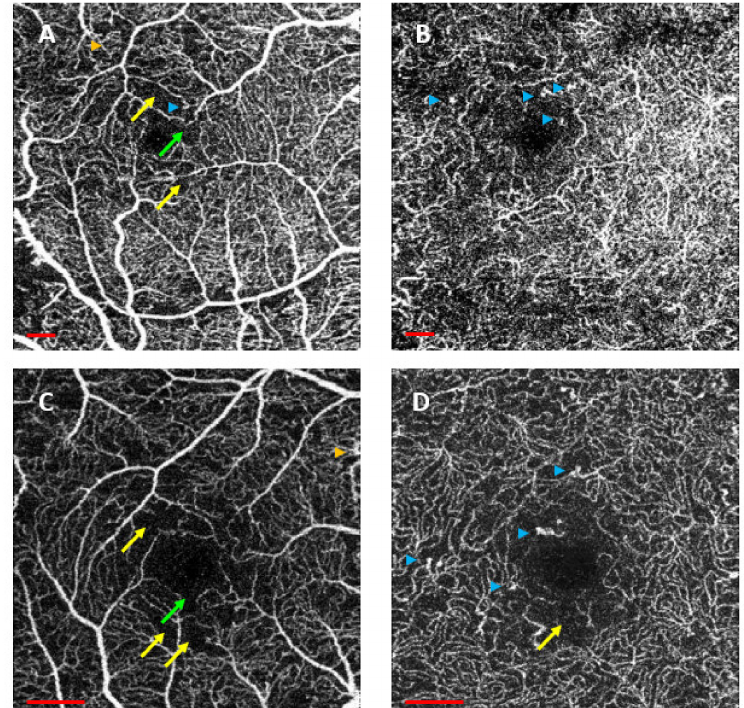
Figure 4. Anatomical changes in the type 2 diabetes mellitus (DM2) group imaged by optical coherence tomography angiography (OCTA). ( A , B ) correspond to the superficial capillary plexus (SCP) and deep capillary plexus (DCP) in a 6 × 6 scan and ( C , D ) to the SCP and DCP in a 3 × 3 scan protocol. ( A , B ) show microaneurysms in both the SCP ( A ) and DCP ( B ). ( C , D ) show foveal avascular zone (FAZ) disruption, perfusion loss and intraretinal microvascular abnormalities (IRMAs) in both the SCP ( C ) and DCP ( D ). Microaneurysms are shown as blue arrowheads, FAZ disruption as green arrows, nonperfusion areas as yellow arrows and IRMA as orange arrowhead. Scale bar (in red) represents 500 µ